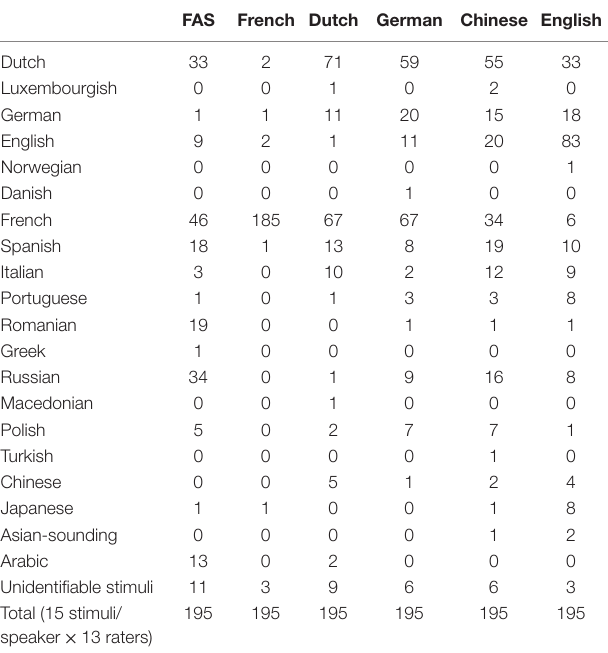
taBLe 8 | perceptual accent rating experiment: correspondence table presenting the frequency of each response (1, 2, 3, 4, 5, 6, or 7) for the patient and each of the control speakers.